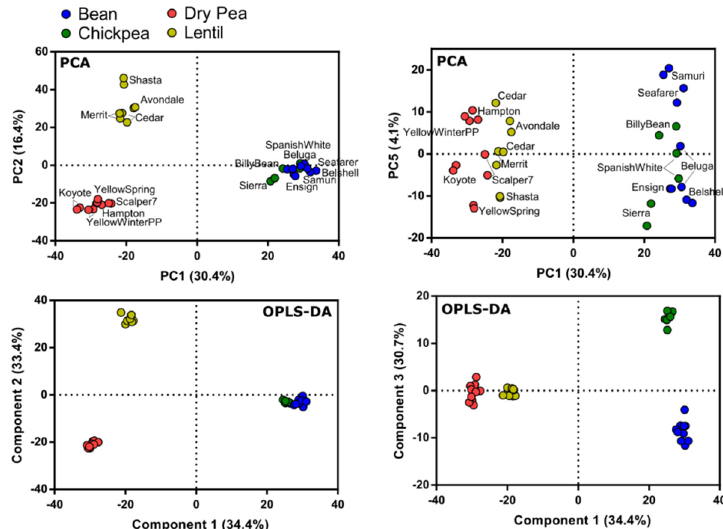
Figure 4. Metabolite variation among pulse types. Principal component analysis (PCA, top) and orthogonal projection to latent structures discriminant analysis (OPLS-DA, bottom) was performed on 17 varieties spanning four pulse types. The data matrix consisted of 2433 metabolites for n = 2 replicates per variety. Figures are scores plots for select components of the PCA and OPLS-DA.